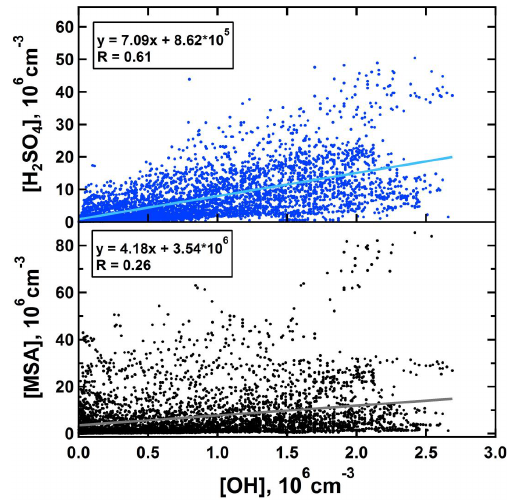
Figure 3. Correlation between H 2 SO 4 and OH (top) and be- tween MSA(g) and OH concentrations (bottom) in marine air for the period May–August 2011 (5min integrated data; daytime: 08:00–20:00UTC). To match the measured data in time OH